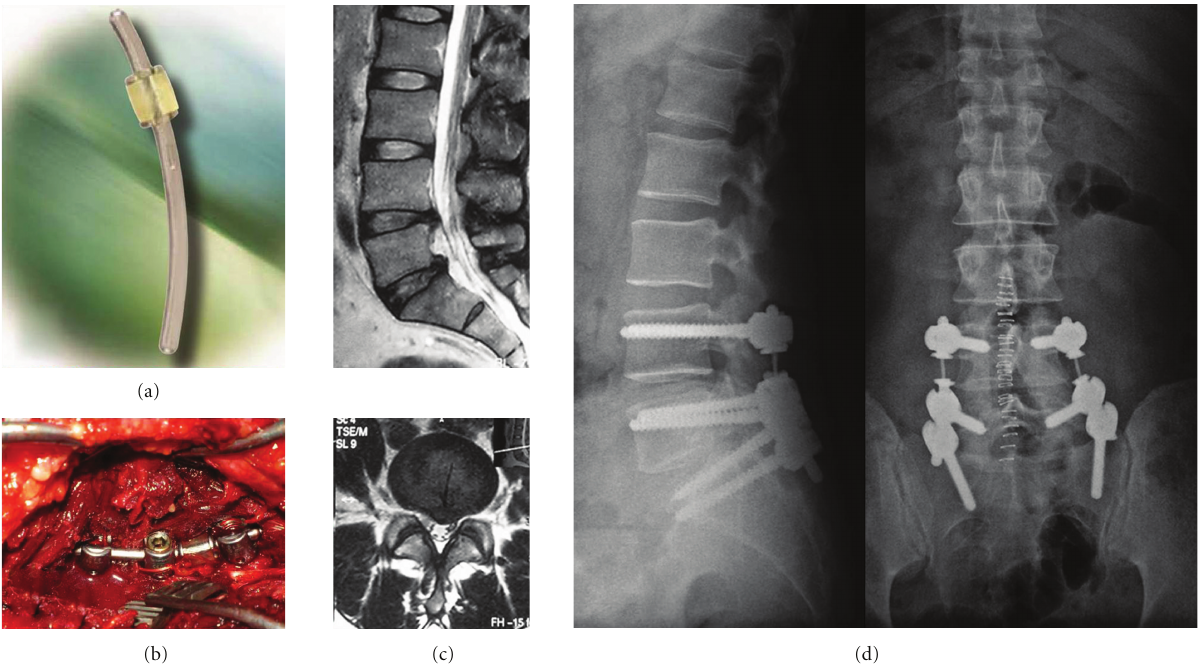
Figure 14: ((a) and (b)) Agile rod; (c) 40-year-old male patient with severe right leg pain; (d) agile rod was applied, and the patient was in very good condition in postoperative year